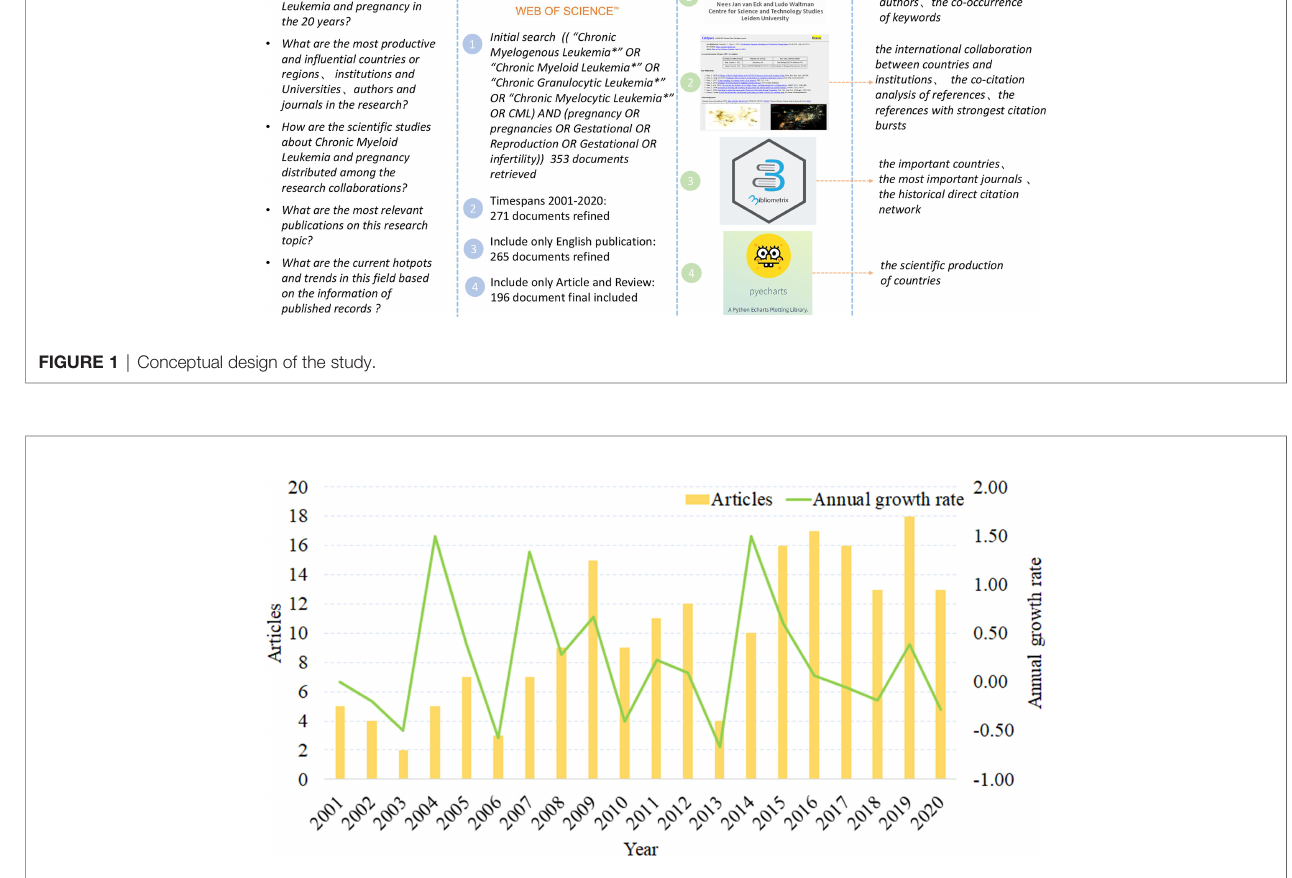
FIGURE 2 | Literature growth curve (2001 to